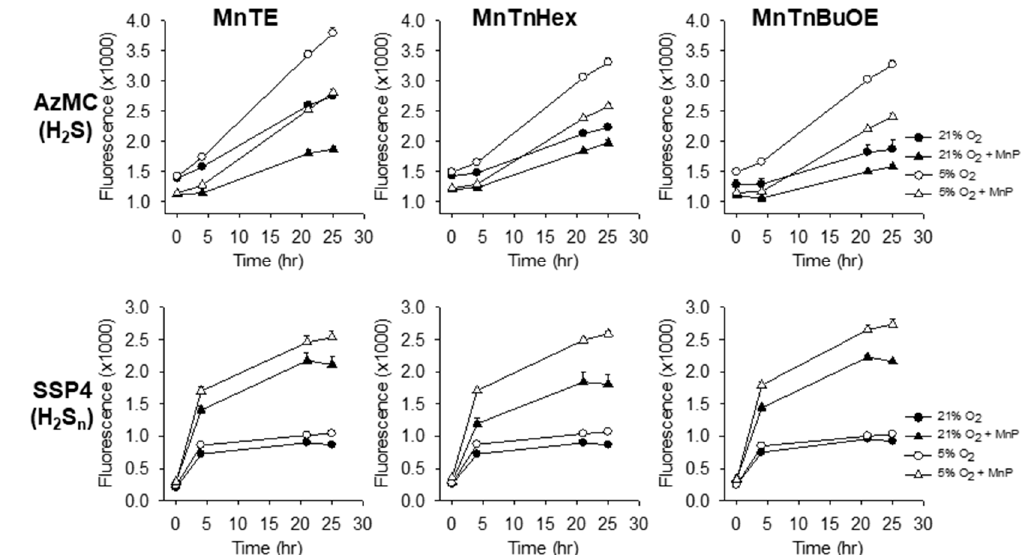
Figure 1. Effects of 3 μ M MnPs on H 2 S (AzMC) and polysulfide (H 2 S n ; SSP4) in HEK 293 cells in hyperoxia (21% O 2 , solid symbols) and physioxia (5% O 2 , open symbols). Intracellular H 2 S were increased in physioxia compared to hyperoxia ( p < 0.001 ), whereas polysulfides were unaffected. All MnPs decreased intracellular H 2 S and increased intracellular polysulfides in both O 2 environments ( p < 0.001 ). Mean + SE, n = 16 wells per treatment, error bars may be covered by symbols.